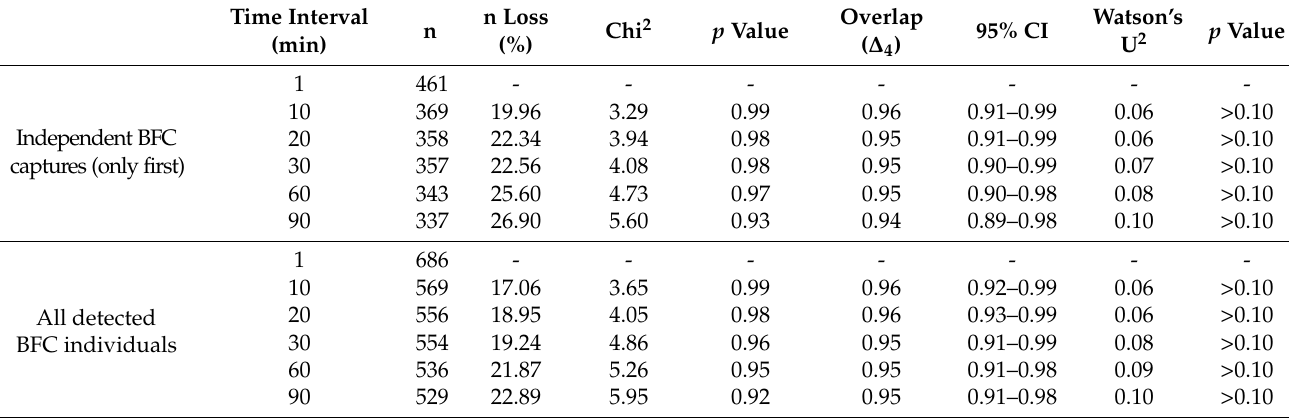
Bare-faced Curassow ( Crax fasciolata ) obtained in the Northern Pantanal (Mato Grosso, Brazil)